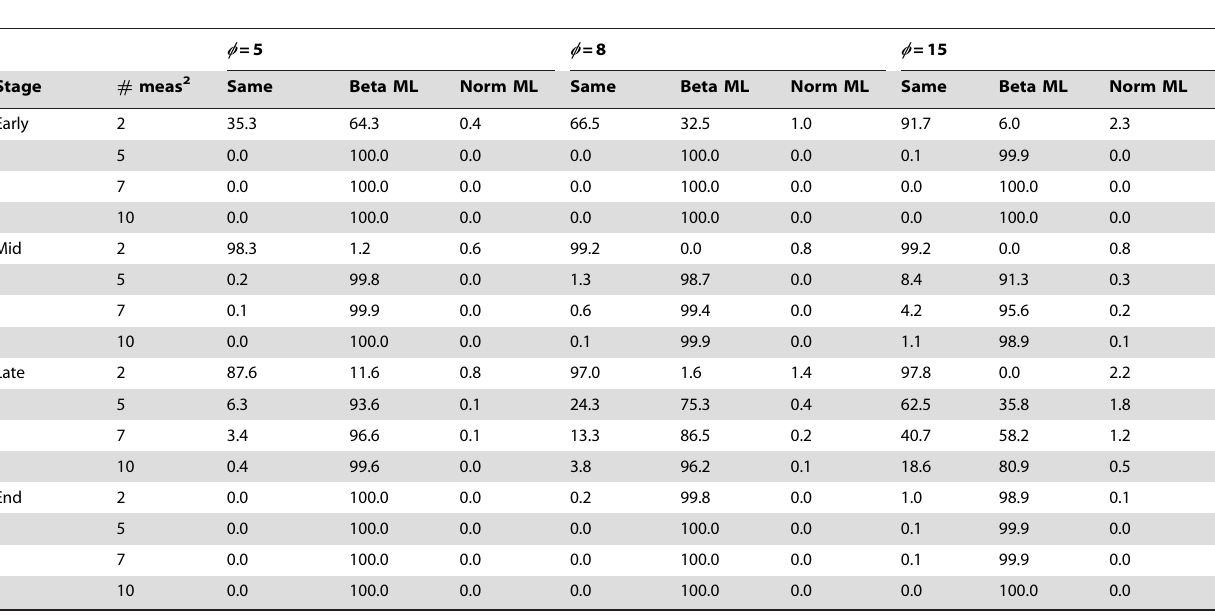
Table 3. Percent of simulations using beta errors (option 2) for which AIC c selected maximum likelihood (ML) estimation with beta or normal errors best or found no difference between the two models (Same) from each simulation ( k=